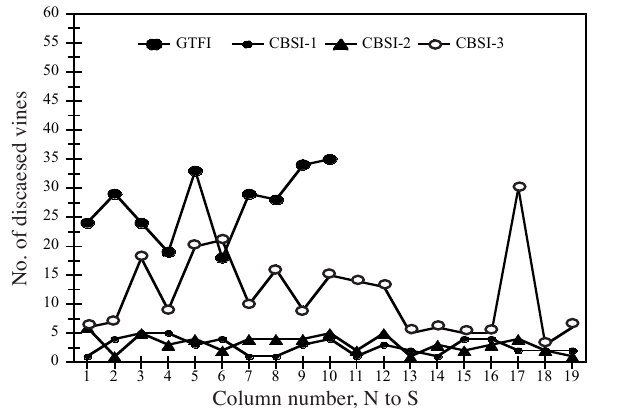
Fig. 8. Number of diseased vines per column in four vine- yards at Gambassi Terme (GTFI) and Castelnuovo Be- rardenga (CBSI-1, 2 and 3).